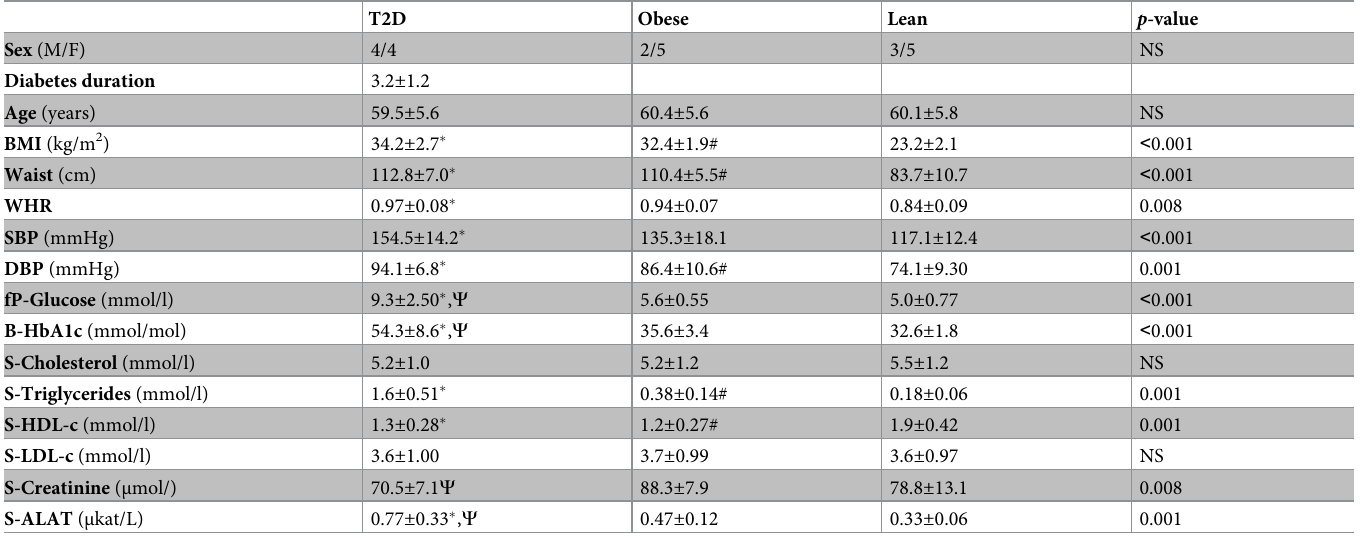
Table 2. Characteristics of the study participants.